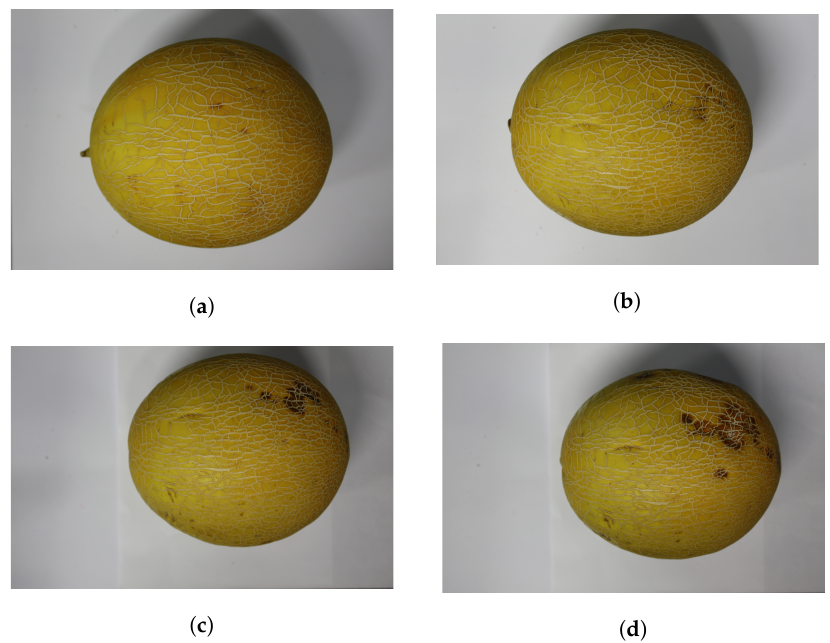
Figure A1. State of the a fruit after ( a ) arrival and after a shelf life of ( b ) one week, ( c ) two weeks and ( d ) three weeks.